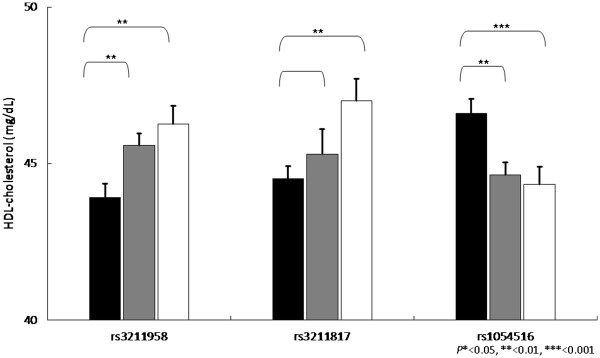
Impact of CD36 gene on HDL-cholesterol levels (mg/dL ± SE) from pairwise genotype comparisons. Adjusted mean HDL-cholesterol for non-carriers (black bars), for heterozygous (gray bars) and subjects homozygous for the minor allele (white bars). Sample sizes (n for non-carriers, heterozygous, and homozygous subjects for SNP (rs3211958), n = 305, 432, 174, for SNP (rs3211817), n = 377, 416, 115, and for SNP (rs1054516), n = 281, 444, 187, resulting co-dominant P-values as 0.002, 0.010, and 0.0008.